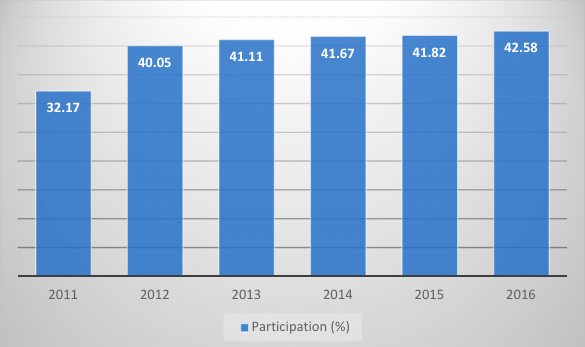
Figure 1. Share (%) of OTC preparations (without dietary supplements) in the drug market in Poland, 2011–2016. Source: own study based on [10].